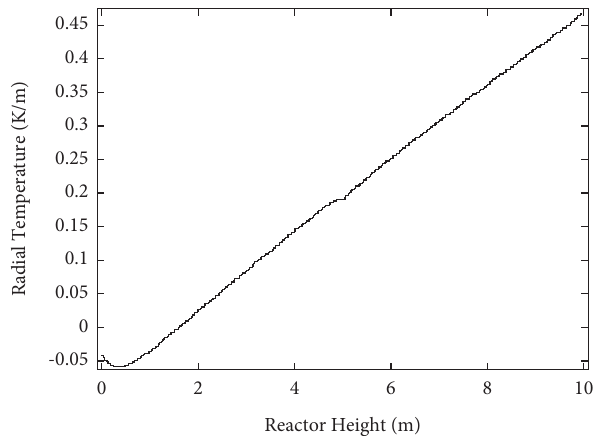
Figure 4: Radial temperature gradient along the